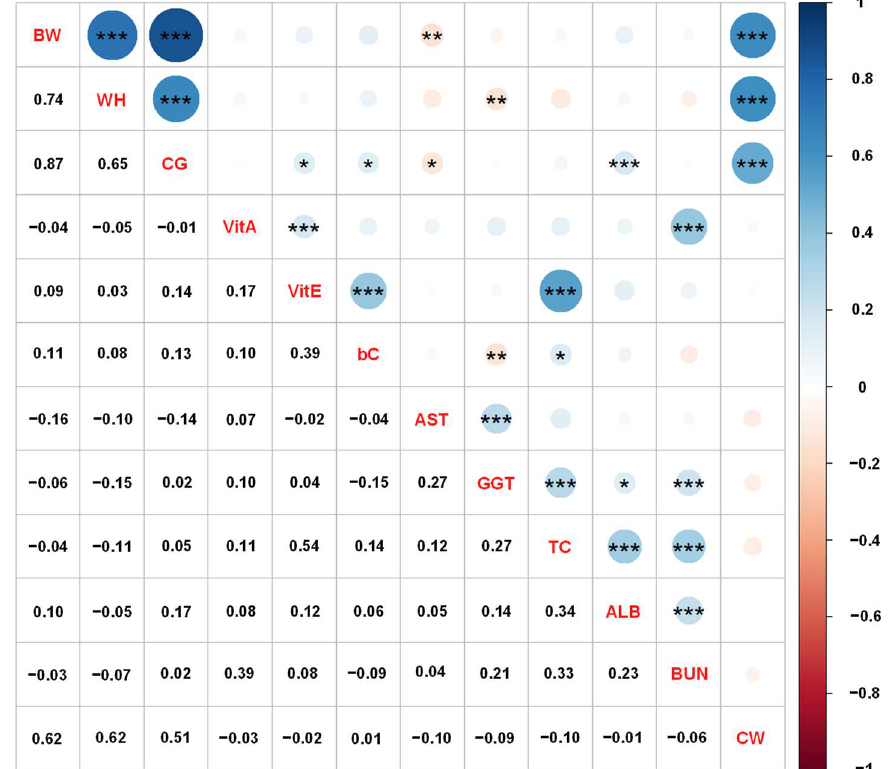
Figure 1. Phenotypic correlation coefficients among the growth performance, blood metabolites, and carcass weight (CW) in Japanese Black cattle. The correlation coefficients are shown on the lower diagonal, and the blue and red colors of the circles on the upper diagonal indicate positive and negative correlations, respectively. Significances of correlation coefficients are shown as asterisks accordingly * : p < 0.05, ** : p < 0.01, and *** : p < 0.001 on the upper diagonal. Abbreviations of traits are shown in Table 1.